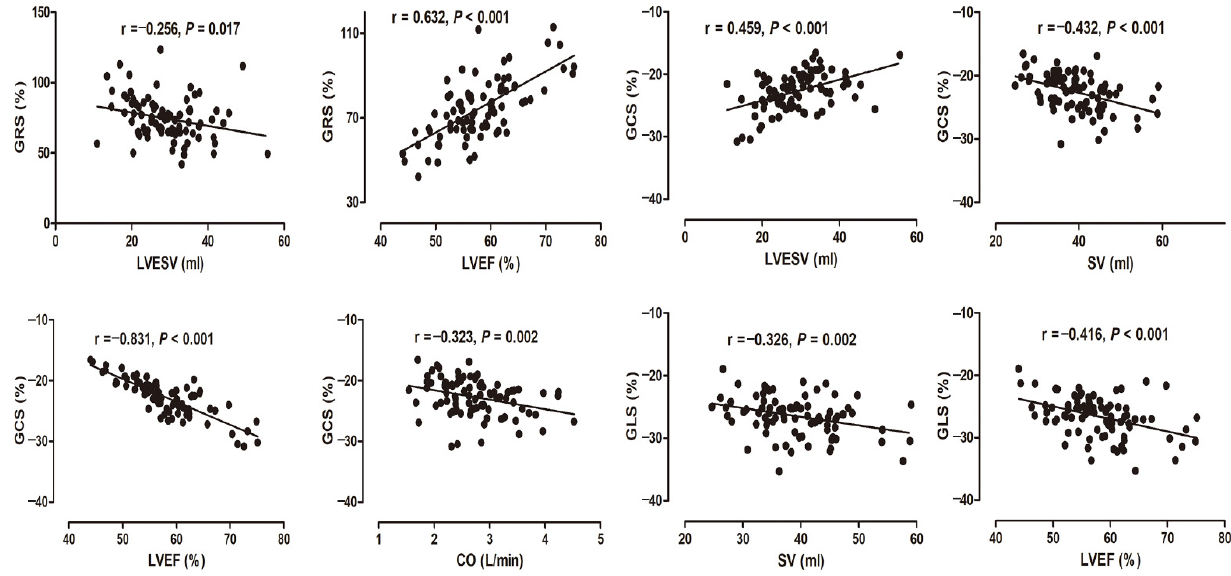
Figure 7. The correlation analysis between left ventricular global myocardial strain and left ventricular function parameters. GRS: global radial strain; GCS: global circumferential strain; GLS: global longitudinal strain. LVEDV: left ventricular end-diastolic volume; LVESV: left ventricular end-systolic volume; SV: stroke volume; CO: cardiac output; LVEF: left ventricular ejection fraction. Furthermore, univariate and multivariate regression analysis for global myocardial strains and clinical indicators and cardiac function parameters are shown in Table 5. Both